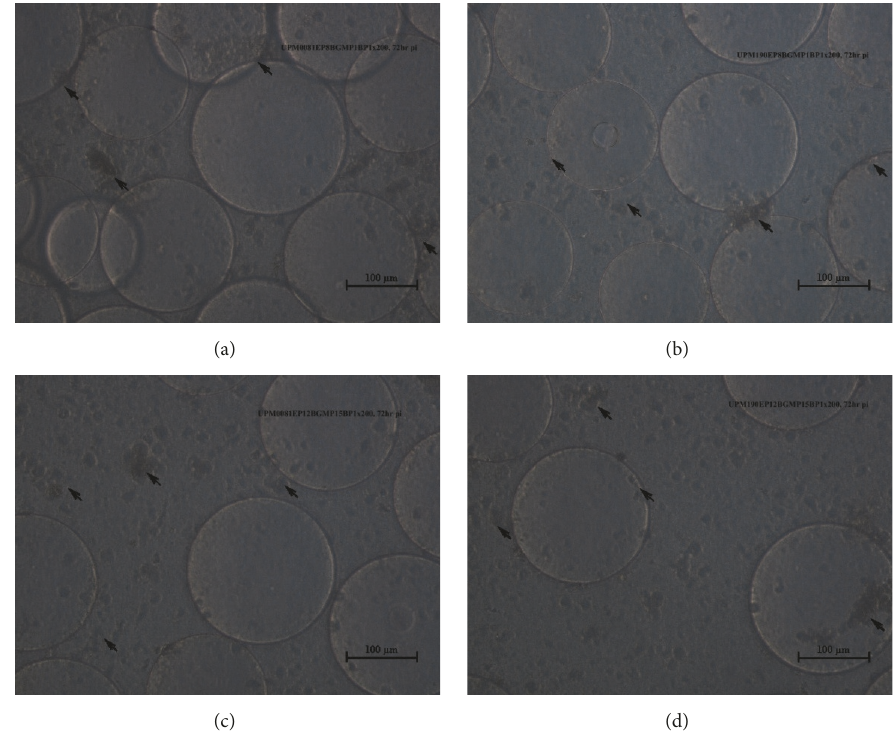
Figure 2: vvIBDV infected BGM-70 cells detaching from cytodex. (a) Detachment of BGM-70 cells from microcarriers at 72 hours pi with UPM0081EP8BGMP1BP1. (b) Detachment of BGM-70 cells from microcarriers at 72 hours pi with UPM190EP8BGMP1BP1. (c) Detachment of BGM-70 cells from microcarriers at 72 hours pi with UPM0081EP12BGMP15BP1. (d) Detachment of BGM-70 cells from microcarriers at 72 hours pi with UPM190EP12BGMP15BP1. Bar=100 𝜇 m.